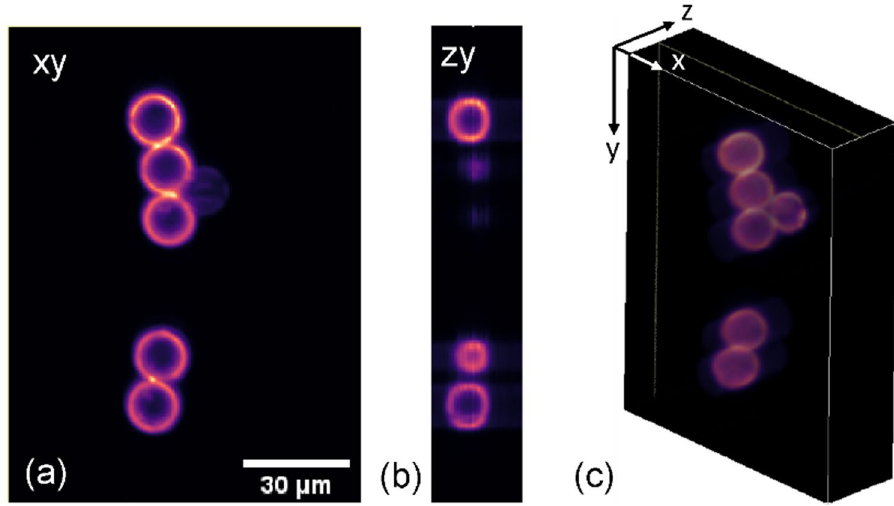
Figure 5. Sections and volume view of 15 µm surface stained microbeads. ( a ) xy slice of image volume, showing clear rings with negligible background, ( b ) zy section and ( c ) volume view of surfaces.